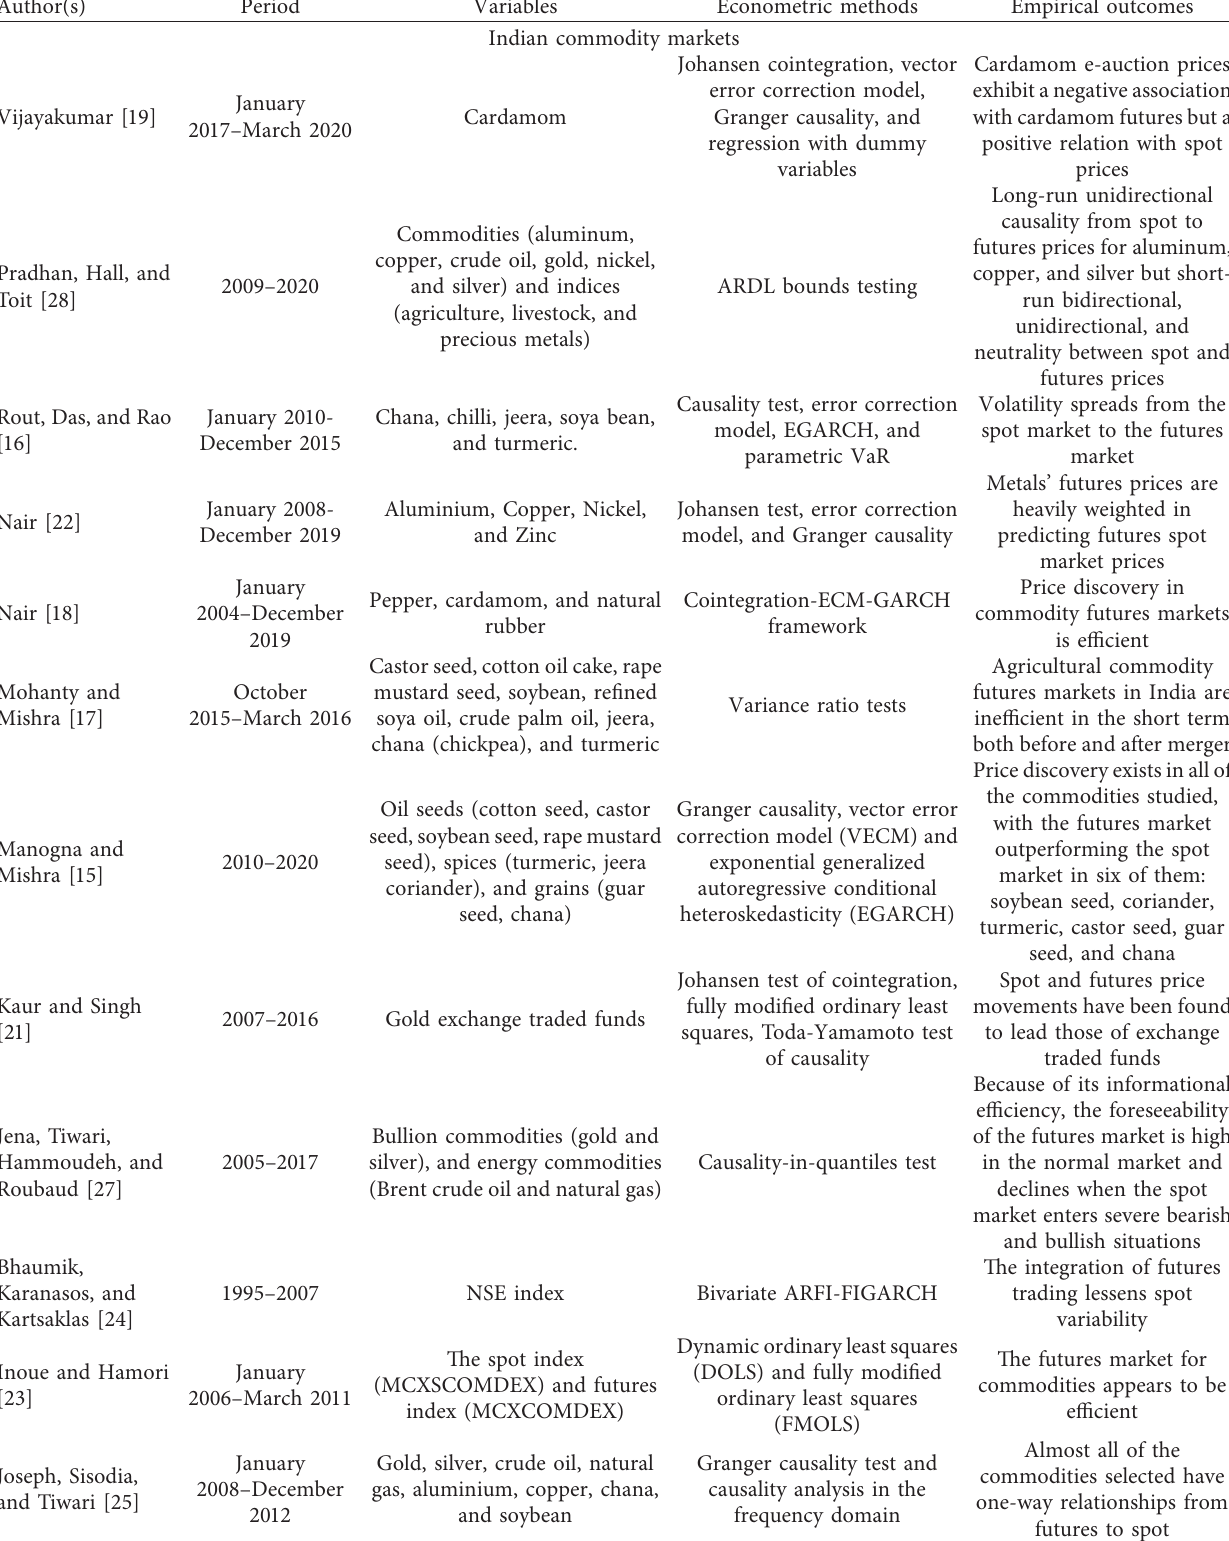
Table 1: Summary of earlier studies regarding price discovery in commodity futures